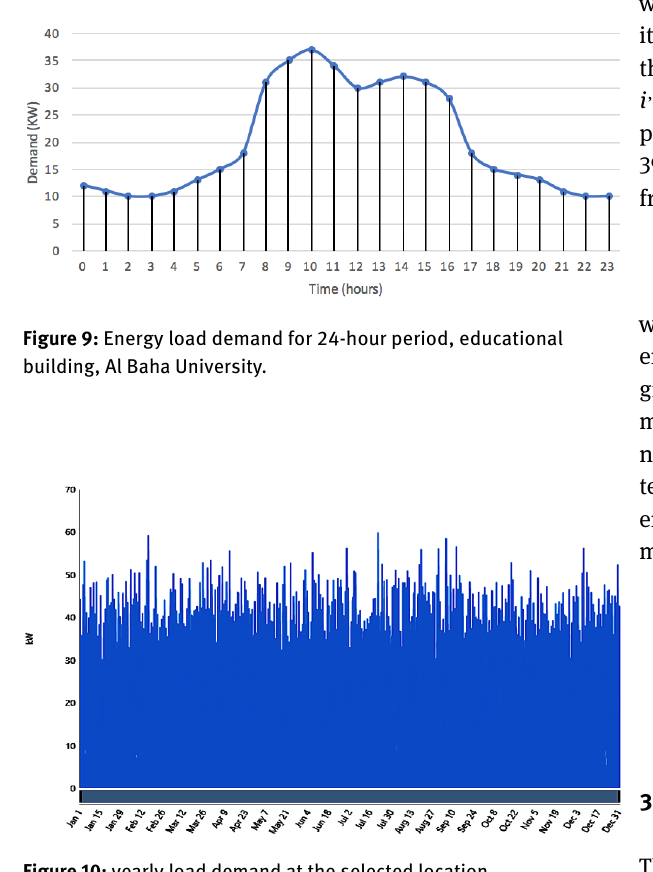
Figure 10: yearly load demand at the selected